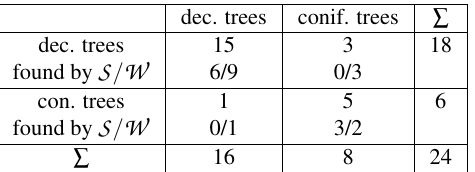
Table 2: Preliminary results of tree classification dec.